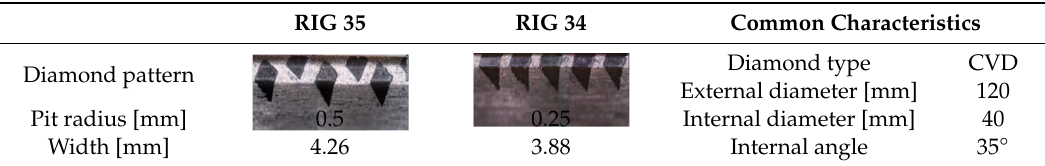
Table 1. Characteristics of rotary dressing tools.